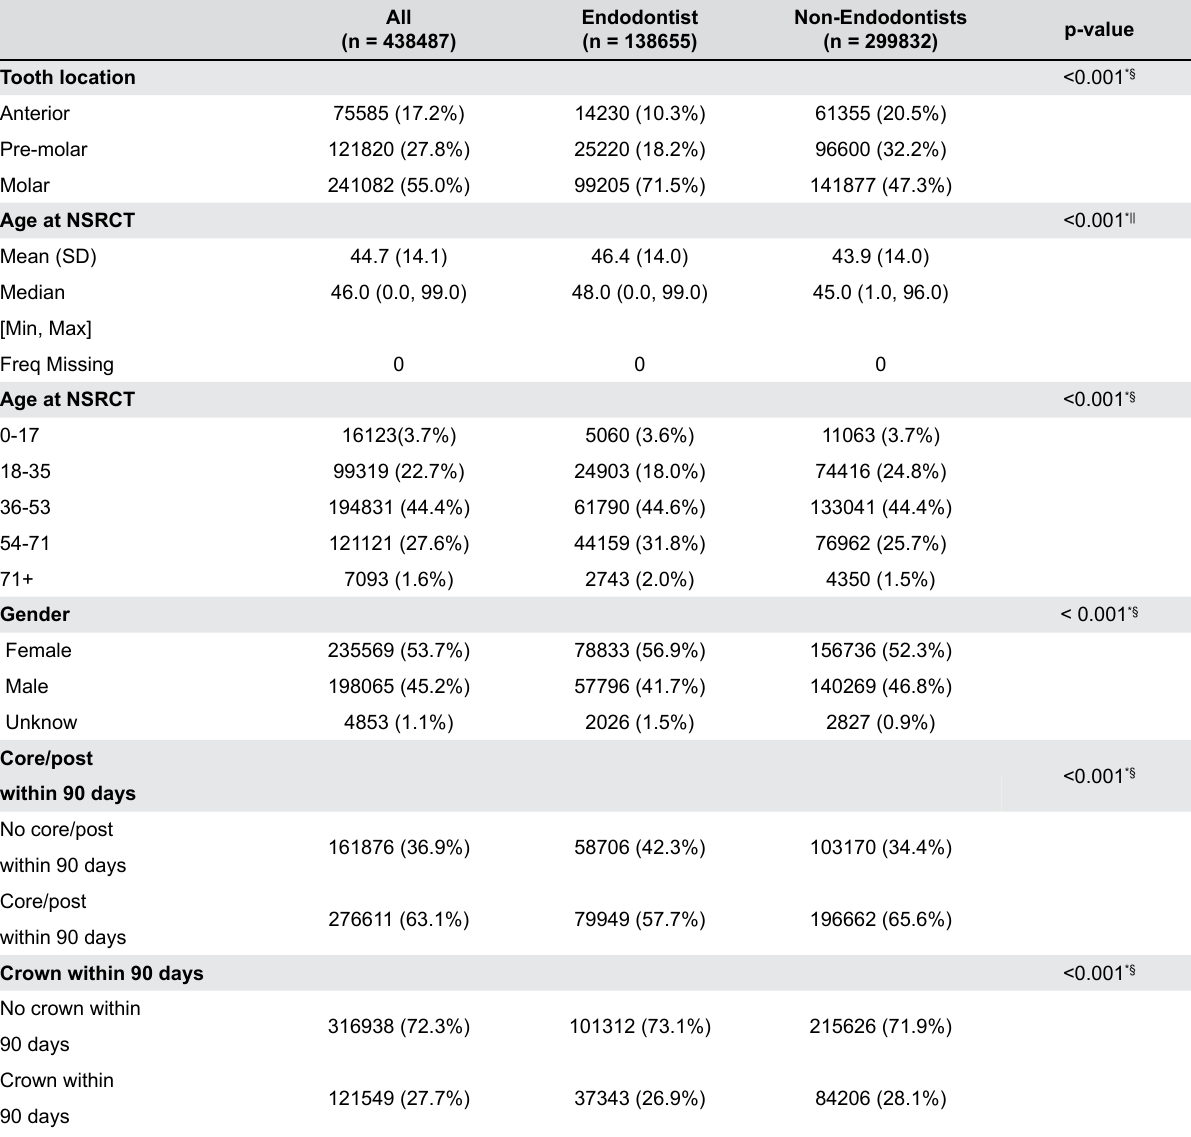
Table 1- Descriptive summary of study